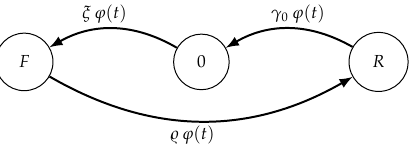
Figure 6. The state diagram of the Markov process N ( t ) with (cid:96) =